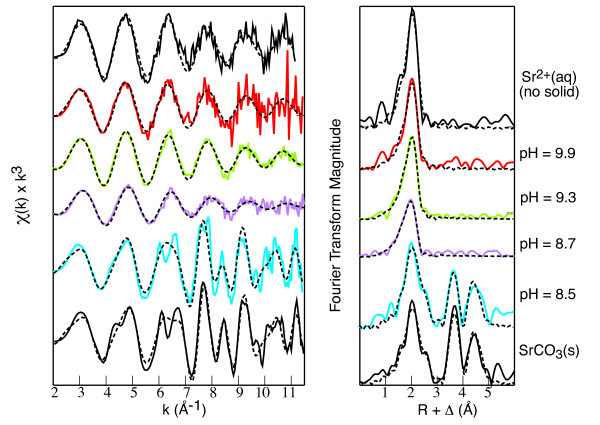
Normalized EXAFS spectra and corresponding radial structural functions for strontium sorbed to goethite and for Sr2+(aq) and SrCO3(s) models (reproduced from Sahai et al., 2000). Solid lines are the data and dashed lines are fits to the data. At pH 8.5 multiple peaks in the radial structural functions reflect Sr-O, Sr-C, and Sr-Sr backscatters that match SrCO3 (s). At higher pH, there is only a single shell of oxygen backscatterers indicated by one peak in the radial structural functions.